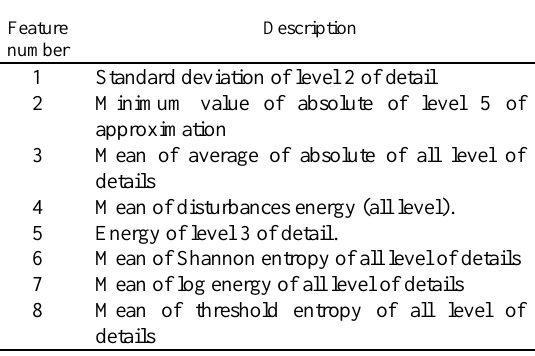
Table 1. Extracted features for detecting scheme